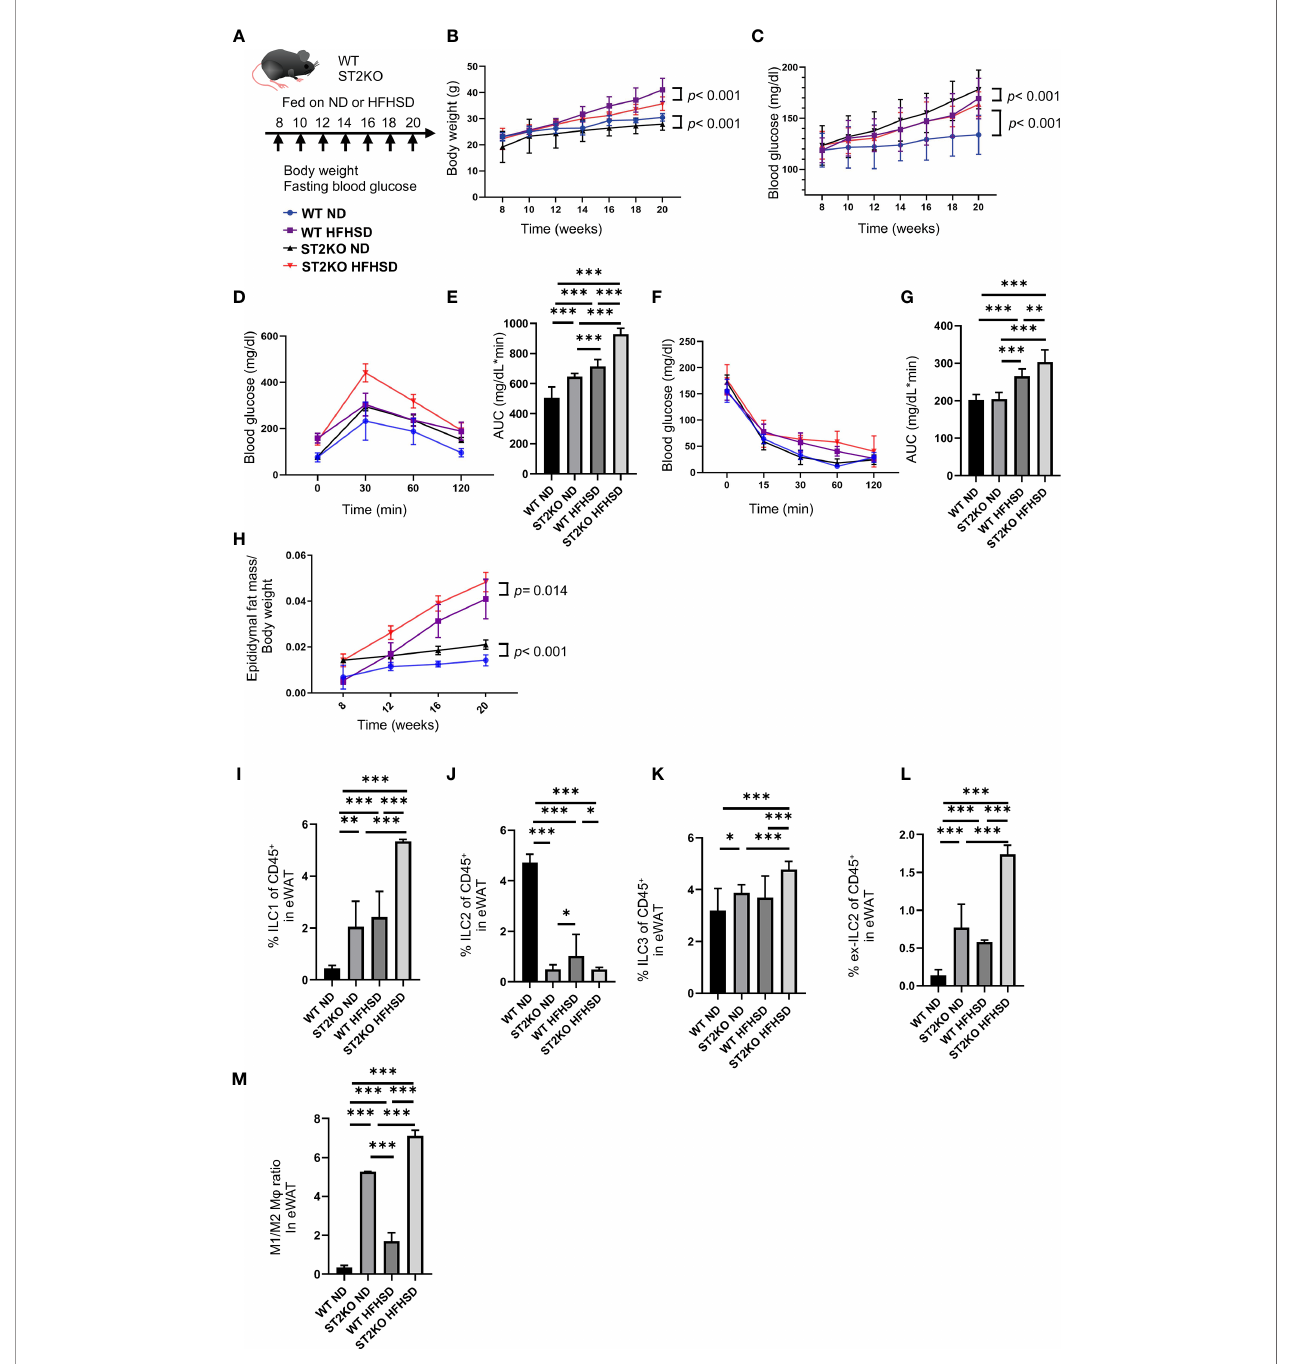
FIGURE 1 | ST2KO mice were not obese but showed increased white adipose tissue and impaired glucose tolerance. (A) Eight-week-old C57BL6/J (WT) mice and ST2KO mice were fed with ND or HFHSD for 12 weeks starting at 8 weeks of age. When the mice reached 20 weeks of age, the mice were sacri fi ced. (B) Body weight changes (n = 12) are shown. (C) Fasting blood glucose levels were measured every two weeks for 12 weeks. (D, E) When the mice reached 20 weeks of age, an intraperitoneal glucose tolerance test (iPGTT) (2 g/kg body weight) was performed and the data ’ s area under the curve (AUC) was analyzed (n = 12). (F, G) At 20 weeks of age, an insulin tolerance test (ITT) (0.75 U/kg body weight) was performed, and the AUC was analyzed (n = 12). (H) The ratio of epididymal fat mass to body weight is shown (8, 12, 16 weeks of age: n = 4, 20 weeks of age: n = 12). (I) The ratio of ILC1s to CD45-positive cells in epididymal white adipose tissue (eWAT) (n = 12). (J) The ratio of ILC2s to CD45 positive cells in eWAT (n = 12). (K) The ratio of ILC3s to CD45-positive cells in eWAT (n = 12). (L) The ratio of ex-ILC2s to CD45-positive cells in peripheral blood (n = 12). (M) The ratio of M1 macrophages in M2 macrophages in eWAT (n = 12). Data are represented as mean±SD; *p < 0.05, **p < 0.01, ***p < 0.001 by one-way ANOVA